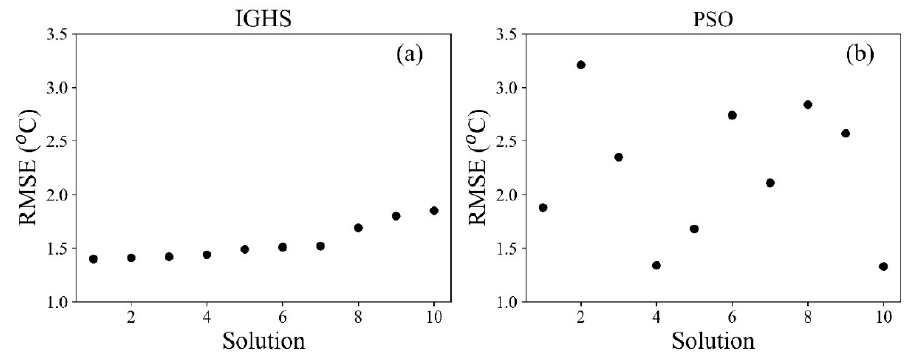
Figure 4. ( a ) IGHS initial memory generated by the opposition-based learning method, and ( b ) PSO initial memory generated by using random search.